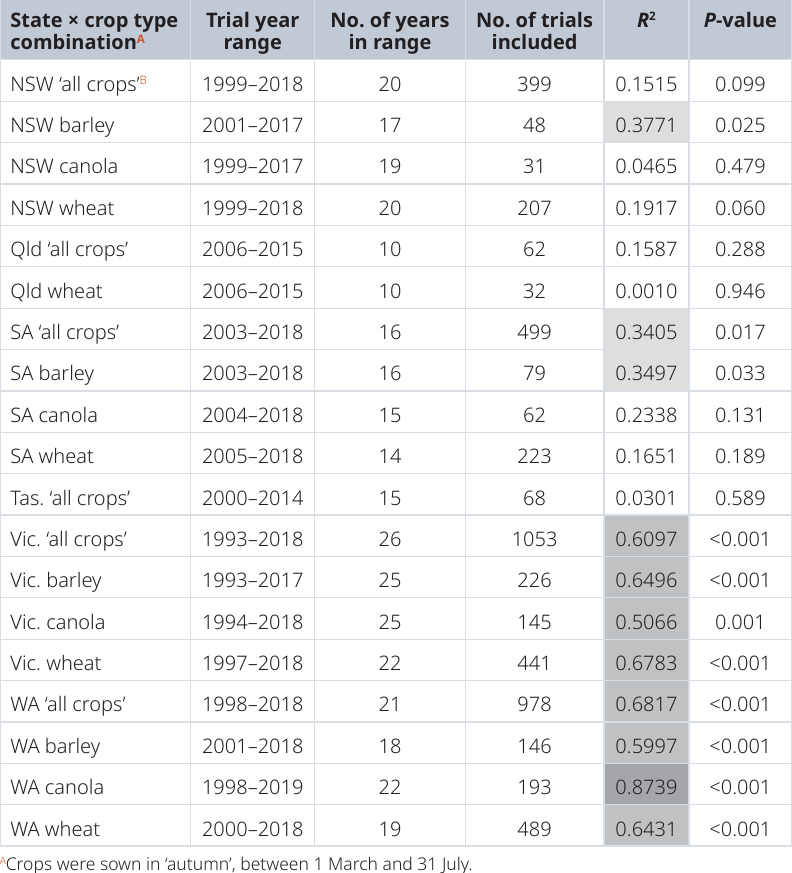
Table 1. Summary of Trial Projects with sowing date (SD) available in the Online Farm Trials database metadata record with > 30 Trial Projects within a state × crop type combination. (NSW = New South Wales; Qld = Queensland; SA = South Australia; Tas. = Tasmania; Vic. = Victoria; WA = Western